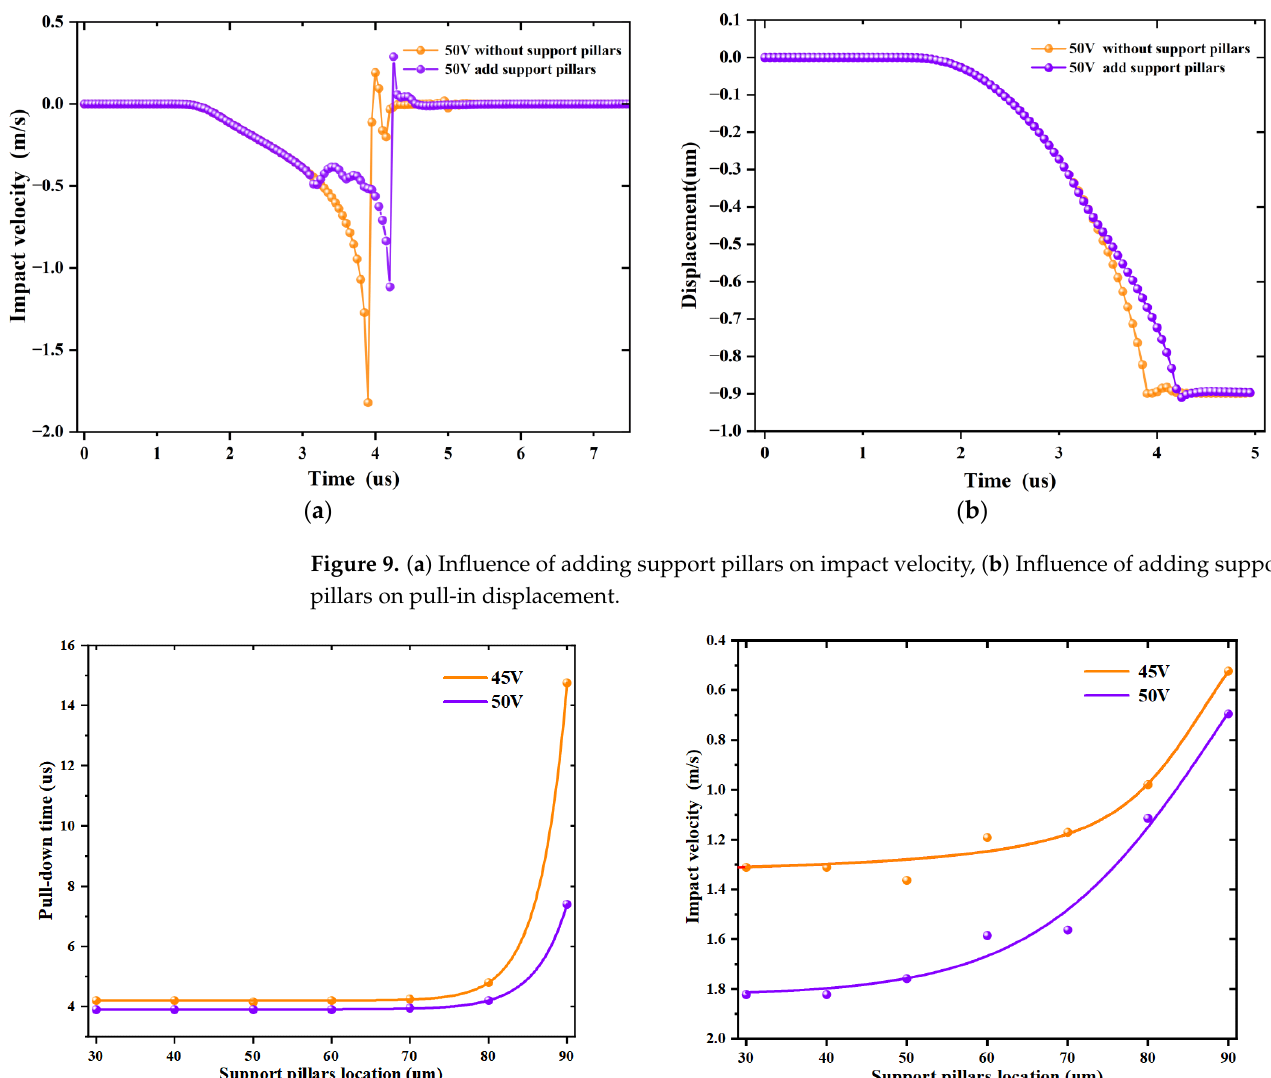
Figure 8. Shape of the beam at different instants of time during pull-down.